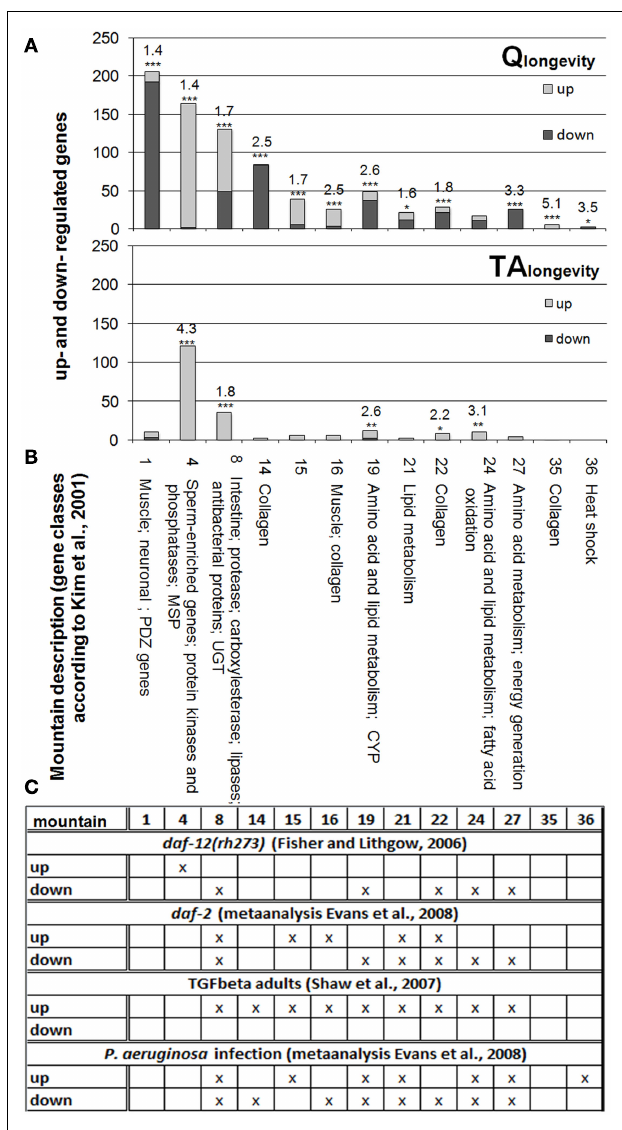
FIGURE 2 | Overrepresented gene expression mountains. Identification of overrepresented gene expression mountains (based on Kim et al., 2001) from Q longevity (A) andTA longevity (B) , as well as from datasets of longevity mutants and P. aeruginosa infected C. elegans (Fisher and Lithgow, 2006; Shaw et al., 2007; Evans et al., 2008) (C) . Depicted are only RFs from mounts which were significantly affected by at least either Q longevity orTA longevity . ∗ p < 0.05, ∗∗ p < 0.005, ∗∗∗ p < 0.001. (The complete dataset and RFs for all 44 gene expression mountains in each and pooled PP concentrations, as well as RFs for previously published datasets can be found in Supplementary Material 4: sheet “Gene Expression Mountains”; results can be reconstructed using the filter function in Supplementary Material